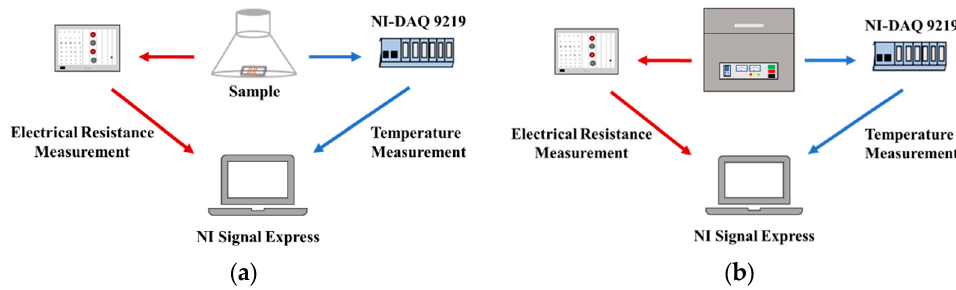
Figure 3. Schematic of the experimental setup for the: ( a ) curing process; ( b ) temperature pro- grams.